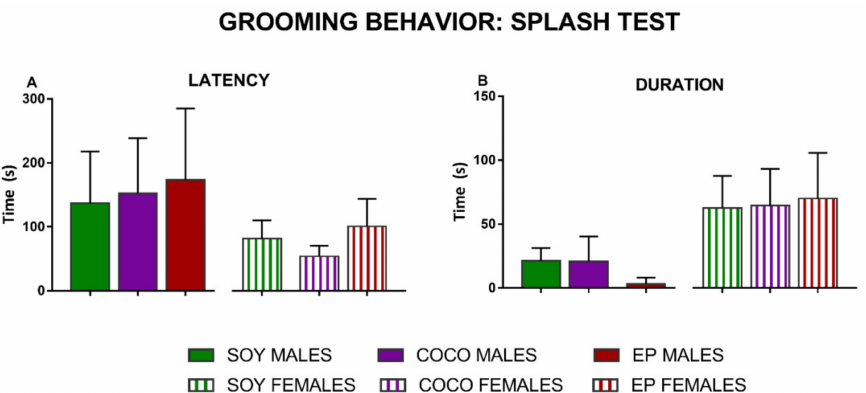
Figure 2. Effects of diet intervention on anhedonia (grooming behavior in the splash test) in the rat. Male and female rats were exposed to AIN-93G diet containing 7% of soybean oil (SOY), or to modified AIN-93G diet containing 3.5% of soybean oil supplemented with 3.5% of coconut oil (COCO) or with 3.5% of evening primrose oil (EP). Both latency ( A ) and duration ( B ) of grooming behavior after sucrose spraying (splash test) were recorded and analyzed in males and females separately. Data are expressed as mean ± S.D. ( n = 6–10 animals per group). One-way ANOVA followed by Bonferroni’s multiple comparison